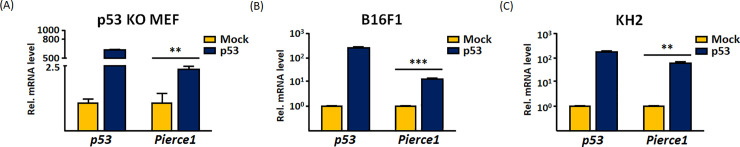
p53-mediated Pierce1 induction in mice.(A–C) Relative p53 and Pierce1 mRNA level determined using qPCR in cells 24 hours after transient transfection with empty vector (yellow bars) or p53 (dark blue bars) in indicated mouse cell lines. p53-deficient mouse embryonic fibroblasts (MEFs, A) and cancer cells (B, melanoma; C, lung cancer) were used for the analyses. GAPDH was used for normalization. Data are presented as mean ± SD (Student’s t-test, **P<0.01, ***P<0.001).